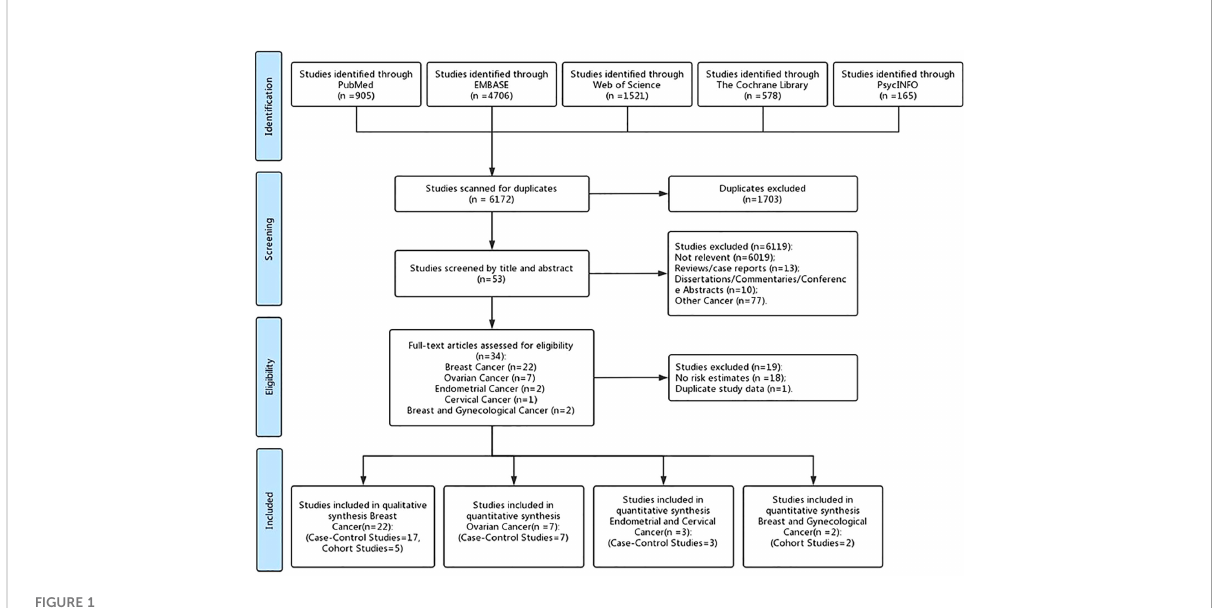
FIGURE 1 Flow diagram of included